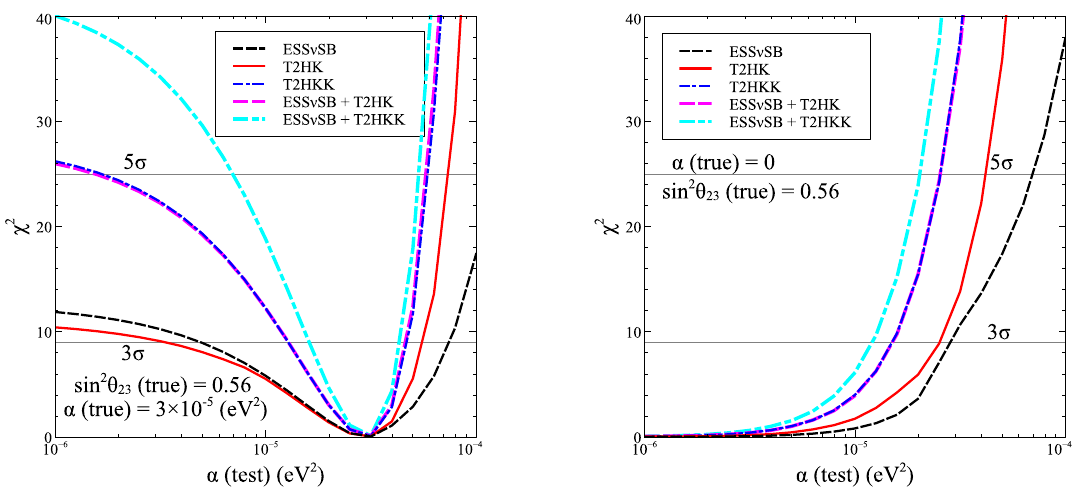
Figure 11 . The χ 2 as a function of test α for various combination of experiments. The left panel is for the case where α = 3 × 10 − 5 (eV 2 ) is assumed for the data and the right panel is for the case where α = 0 in the decay. The black dashed curves are for ESS ν SB, red solid curves are for T2HK, blue dashed-dotted curves for T2HKK, the magenta dashed for combination of ESS ν SB and T2HK and the cyan curves are for combination of ESS ν SB and